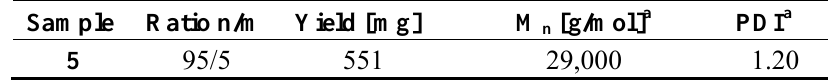
Table 1. Selected characterization data of the precipitated poly(DEGMA- stat -PyMMA).